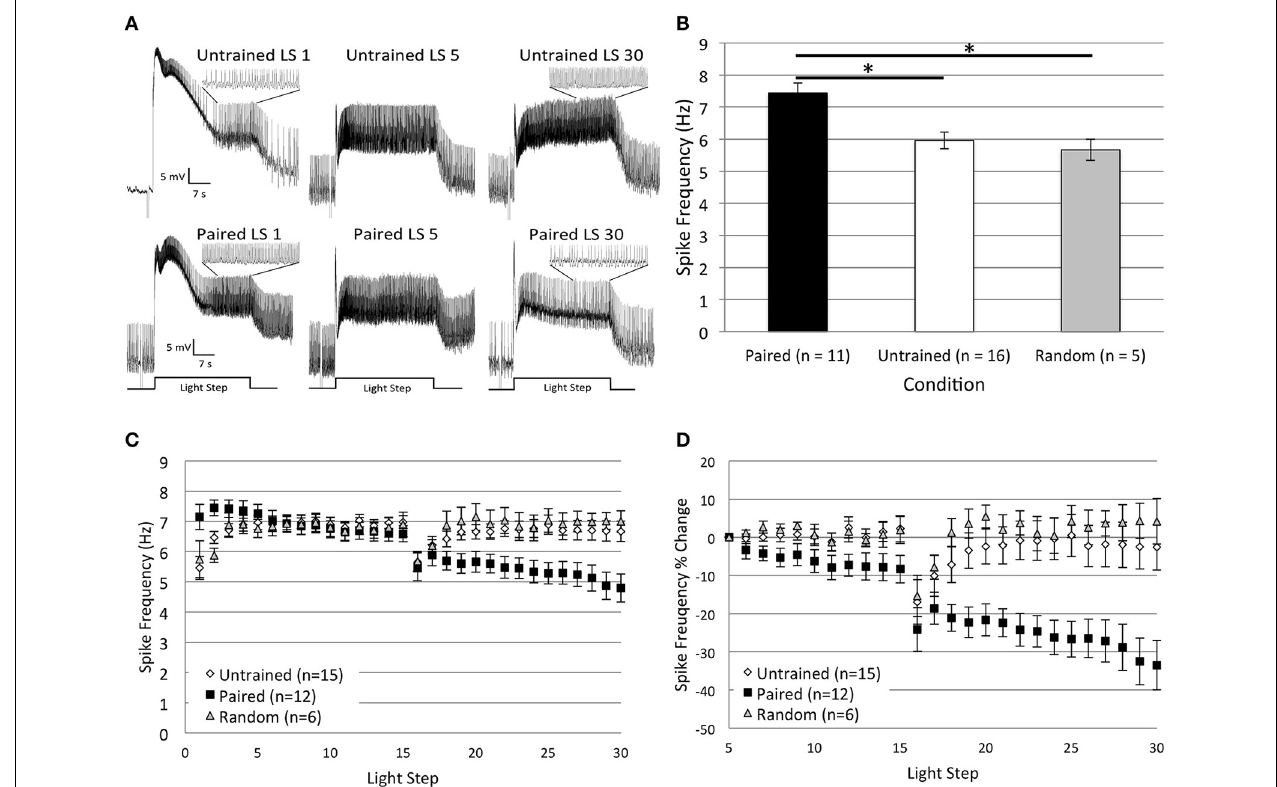
FIGURE 2 | Thirty repeated light presentations (extinction training) produced a progressive reduction in Type B cell spike frequency, but only in paired-trained cells. (A) Representative light responses recorded from either untrained (top traces) or paired-trained (bottom traces) Type B photoreceptors from isolated H.c. nervous systems. Recordings from Paired animals were obtained 2h following the conclusion of paired conditioning. Light-evoked spike frequencies were recorded during two consecutive sets of 15 repeated light steps (LSs), 2min inter-stimulus intervals, separated by a 10min re-dark adaptation period. This procedure served as an in vitro simulation of whole-animal extinction training. Spike frequencies were recorded over the last 10s of each 30s LS. Inset traces above LSs 1 and 30 for both Paired and Untrained cells show expanded time scale during last 10s of LS. Note the more frequent spiking activity in the Paired cell during LS 1 compared to the Untrained cell, indicative of excitability increases due to associative learning. Both cells had approximately equivalent spike frequencies by LS 5, but after this, the Paired cell exhibited a progressive reduction in spike frequency over the course of the next 25 LSs. By LS 30, the Paired cell spiked less frequently than the